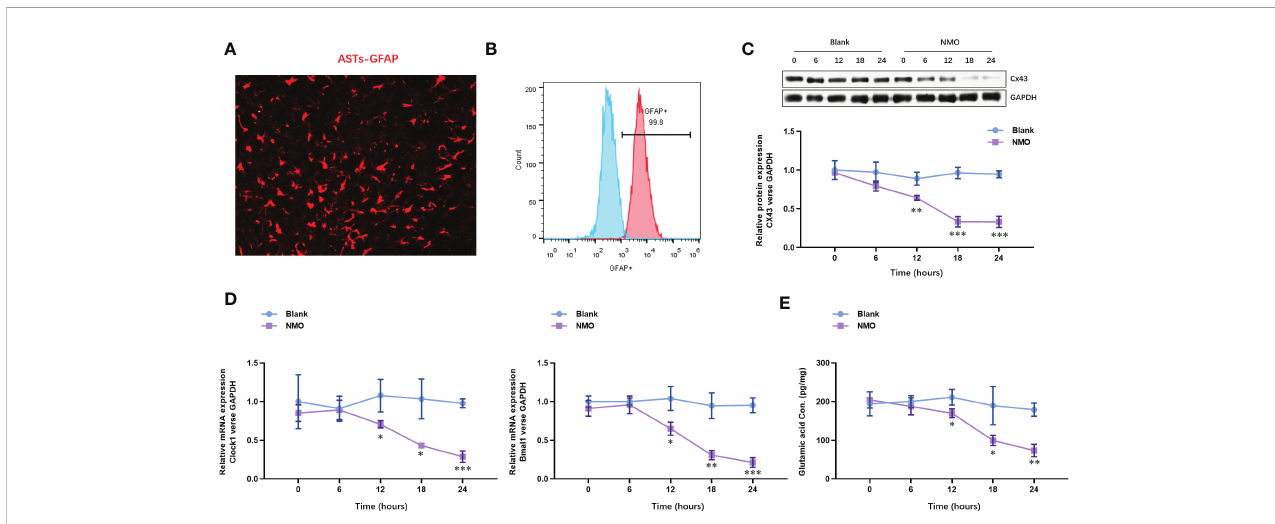
FIGURE 2 The expression of Cx43 protein and circadian rhythm regulating gene (Clock and Bmal1) are time-dependently decreased in astrocytes after NMO induction. (A) The identity of isolated SCN astrocytes was con fi rmed with GFAP by immuno fl uorescence staining. (B) The purity of SCN astrocytes was further con fi rmed by fl uorescence activated cell sorting (FACS) analysis. (C) The protein levels of Cx43 in SCN astrocytes with or without NMO induction were analyzed by Western Blot. (D) The mRNA levels of circadian rhythm regulating genes (Clock and Bmal1) in SCN astrocytes with or without NMO were analyzed by real-time PCR. (E) the levels of Glu in SCN astrocytes with or without NMO-IgG induction were analyzed by ELISA. * P <0.05, ** P <0.01, *** P <0.001, compared with the blank group.